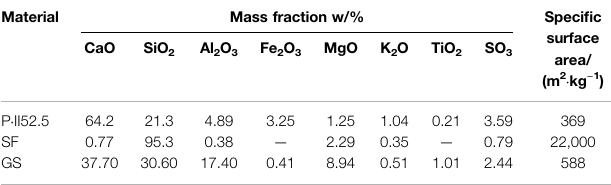
TABLE1| Chemicalcompositionandspeci fi